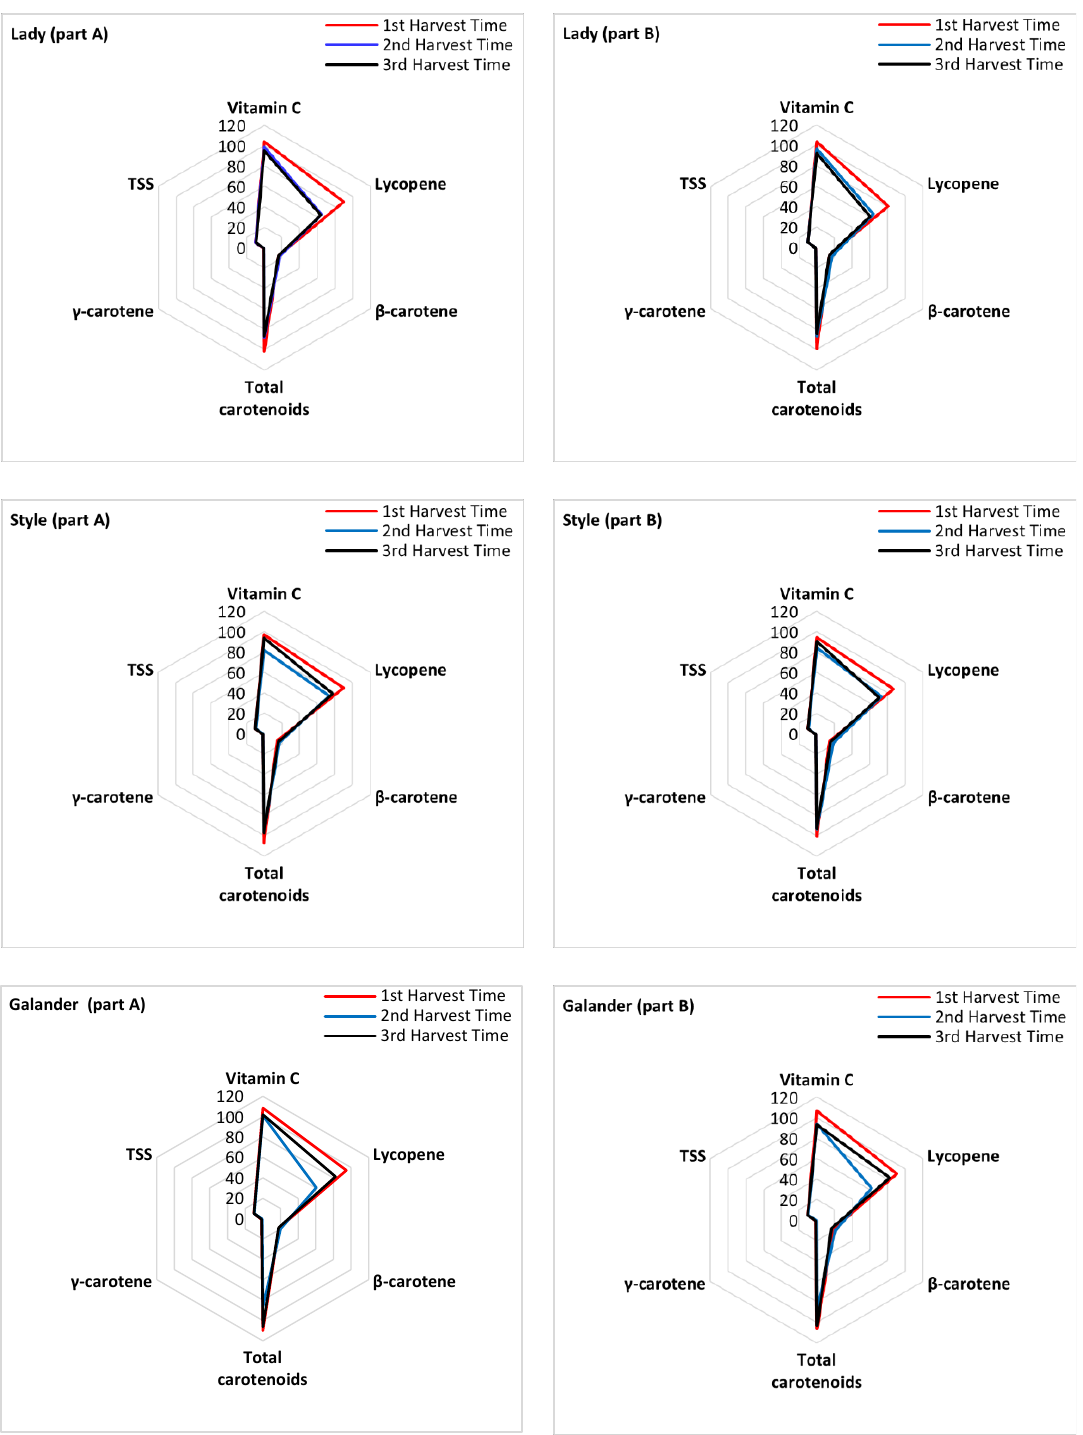
Figure 2. Comparison between Vitamin C, lycopene, β -carotene, total carotenoids, γ -carotene, and TSS values of Lady, Style, and Galander cultivars.